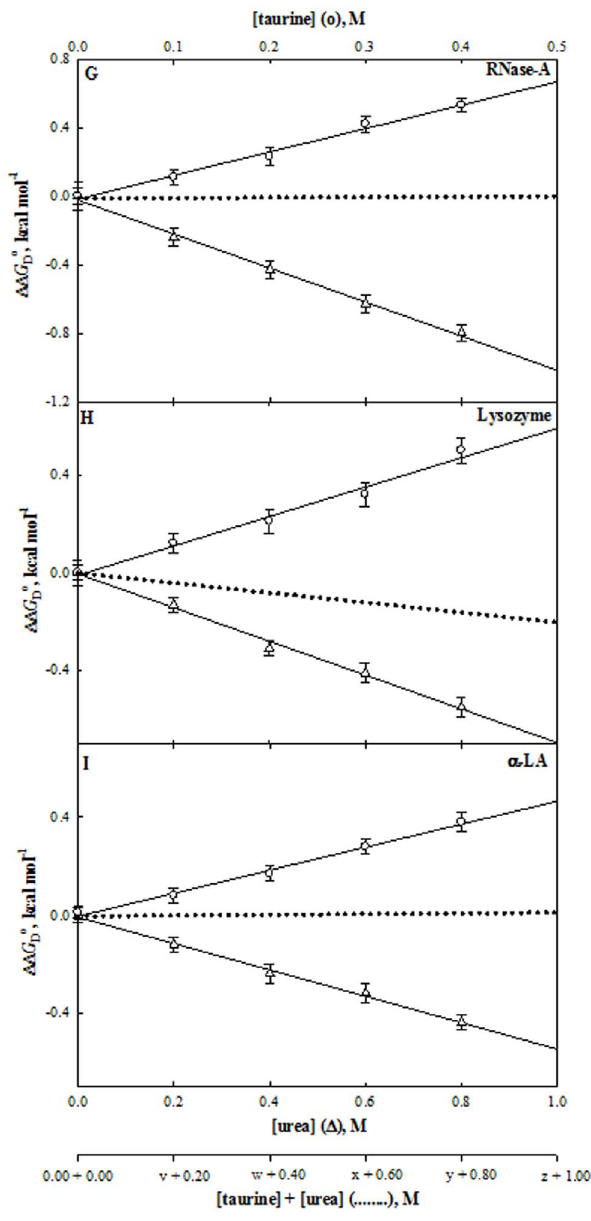
Figure 5. Effect of sorbitol, urea and their mixtures on stability of proteins at pH 7.0 and 25 6 C. Plots of DD G Do versus [sorbitol] ( # ) and [urea] ( D ). The dotted line represents the DD G Do values measured at the predicted ratios (see Table 2). The values of v, w, x, y and z of each protein are those predicted from results given in Table 2. For instance, values of y for sorbitol are 1.20, 1.60 and 1.00 M for RNase-A, lysozyme and a -LA, respectively.